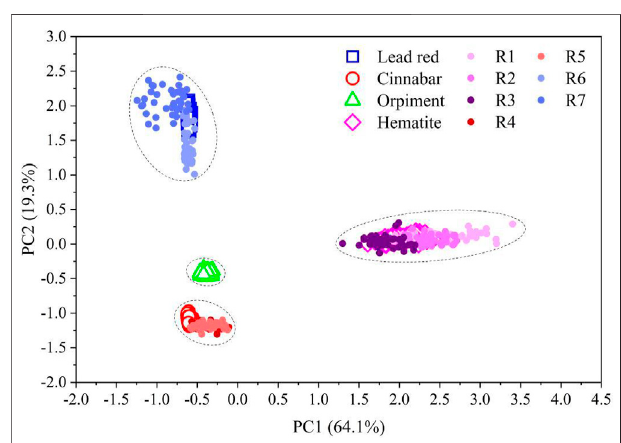
FIGURE 6 | Score plots of PC1 and PC2 for the variance between 250 and 600 nm of R1 – R7 areas on the